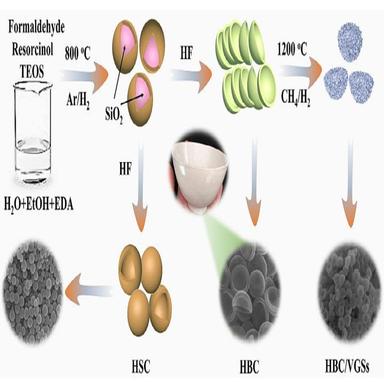
Schematic diagram of synthesizing HSC, HBC (HBC is synthesized in the same way as HSC, except that the dosage of TEOS and resorcinol are changed, and other conditions remain unchanged.) and HBC/VGSs.